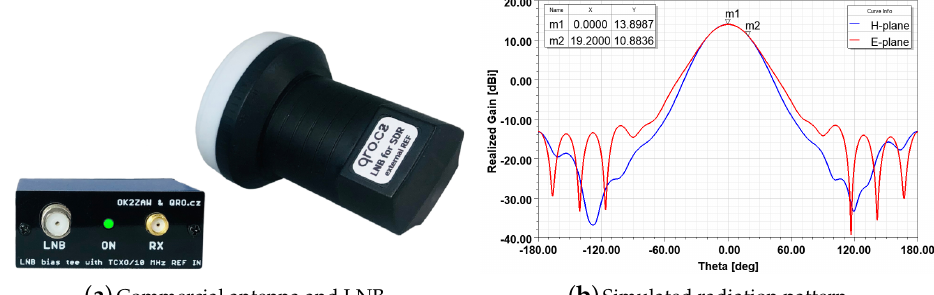
Figure 4. Characterization of commercial axially corrugated conical horn [31].